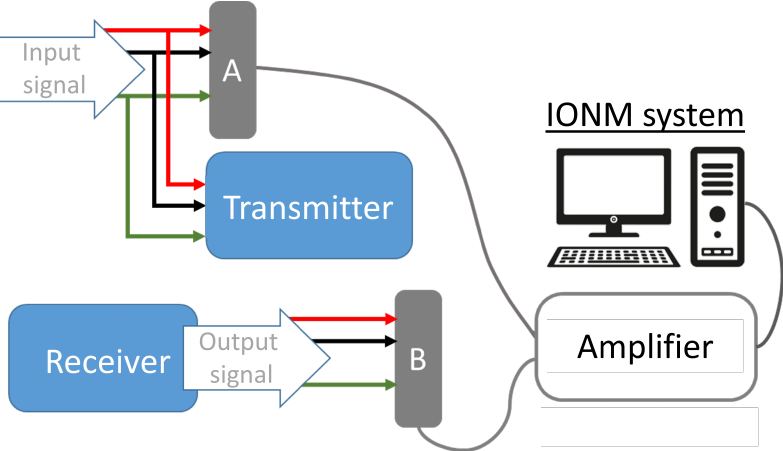
Figure 12. Schematic of the configuration of the performed test.